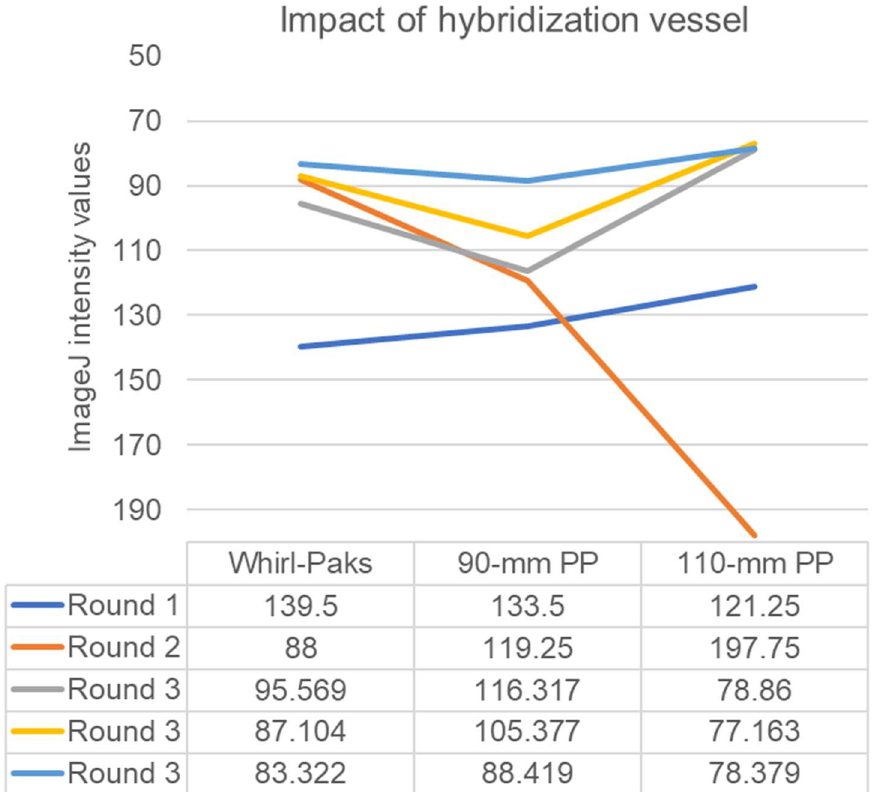
Figure 5. ImageJ intensity values for hybridization steps in heated orbital shaker versus reciprocal shaking heated water bath. Whirl-Pak bags yielded results superior to the 90-mm containers in two out of three probing sessions ( p > 0.05).